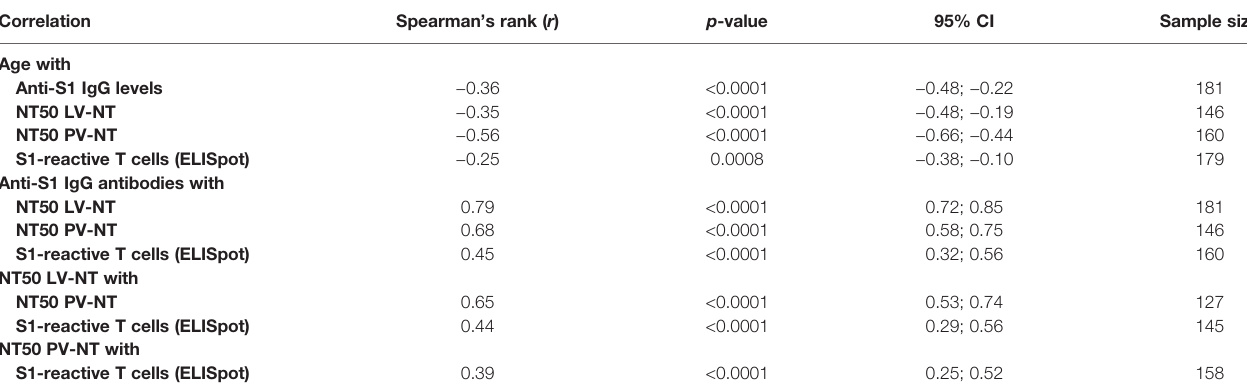
TABLE 2 | Correlations between age and main immune parameters of the postvaccinal response at 3 months in COVID-19-naive young and older participants. Correlation Spearman ’ s rank ( r ) p -value 95% CI Sample